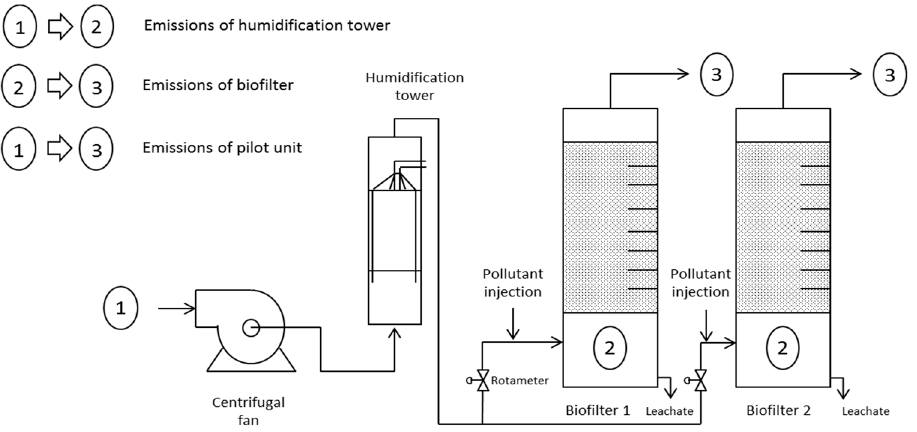
Figure 1. Schema diagram of experimental design with particles sampling points. 1: Ambient air. 2: Gas homogenization area. 3: Gas outlet.